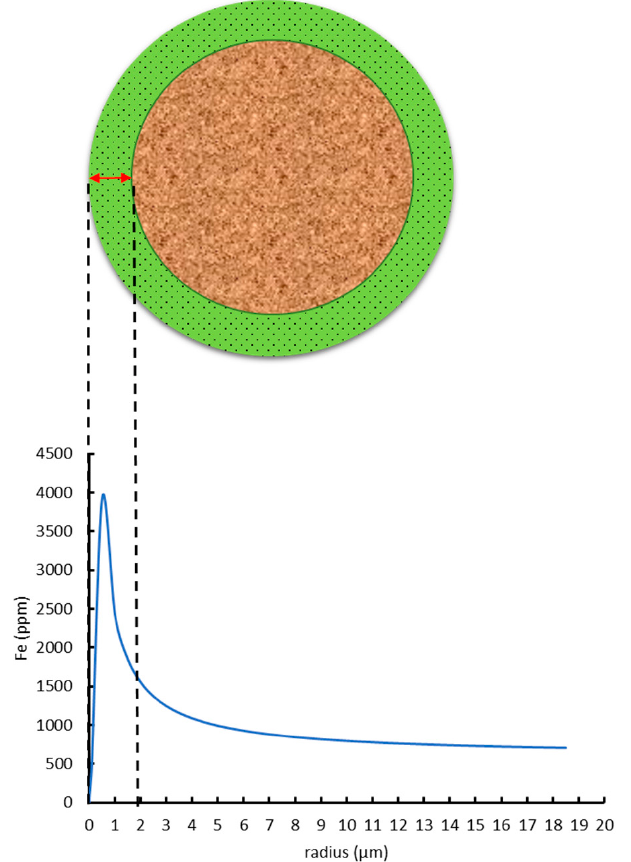
Figure 9. Cross-sectional view of an FCC catalyst particle depicting contaminant metals (Fe, Ni) distribution along its radius. The metals concentrate in the outermost green annular region around the catalyst particle (brown circle).